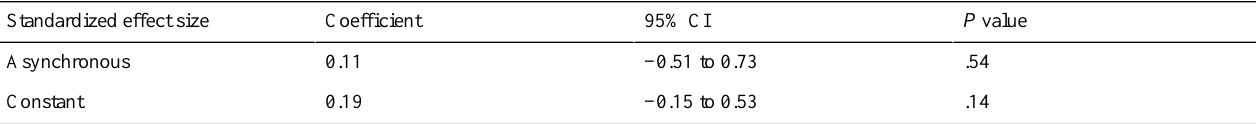
Table 6. Metaregression of synchronous and asynchronous interventions on fatigue outcome, analyzed using standardized effect